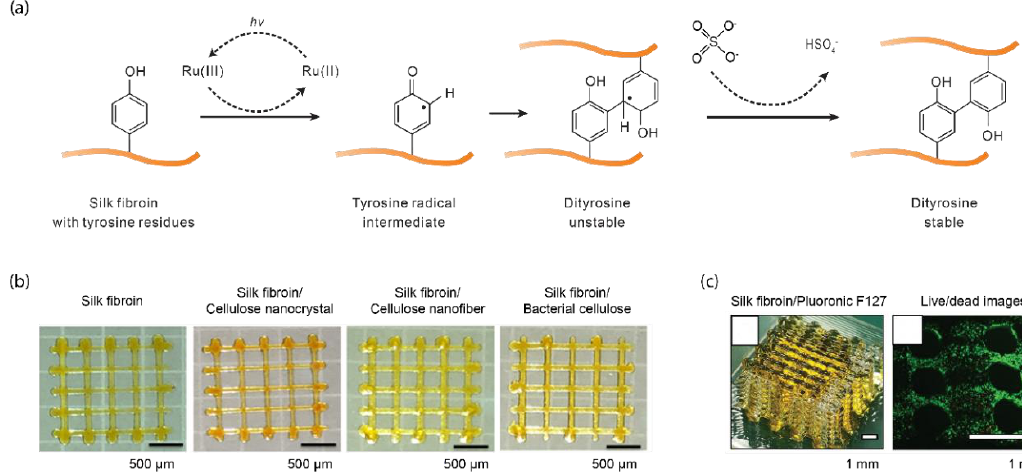
Figure 3. Ru(II) / persulfate-mediatedphoto-crosslinkingofsilkfibroin. ( a )Ru(II)andpersulfate, underlight exposure, are photolyzed into Ru(III) and sulfate radicals, respectively. Ru(III) oxidizes tyrosine residues into a tyrosyl radical intermediate. The tyrosyl intermediate couples with nearby tyrosine residues, which are stabilized by the persulfate radical by removing a hydrogen atom. ( b ) Silk fibroin is blended with nanocellulose materials for 3D printing via extrusion and Ru(II) / persulfate. Reproduced